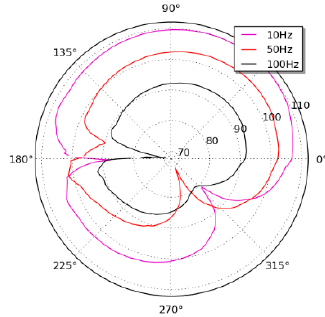
Figure 15. Horizontal directivity of sound pressure of the sail hull in low-frequency range. The pink line denotes the frequency of 10 Hz. The red line denotes the frequency of 50 Hz. The black line denotes the frequency of 100 Hz.